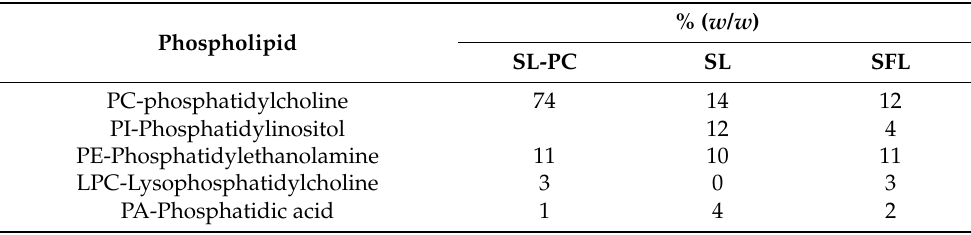
Table 3. Phospholipid composition of soybean lecithin enriched in phosphatidylcholine (SL-PC), soy lecithin (SL) and sunflower lecithin